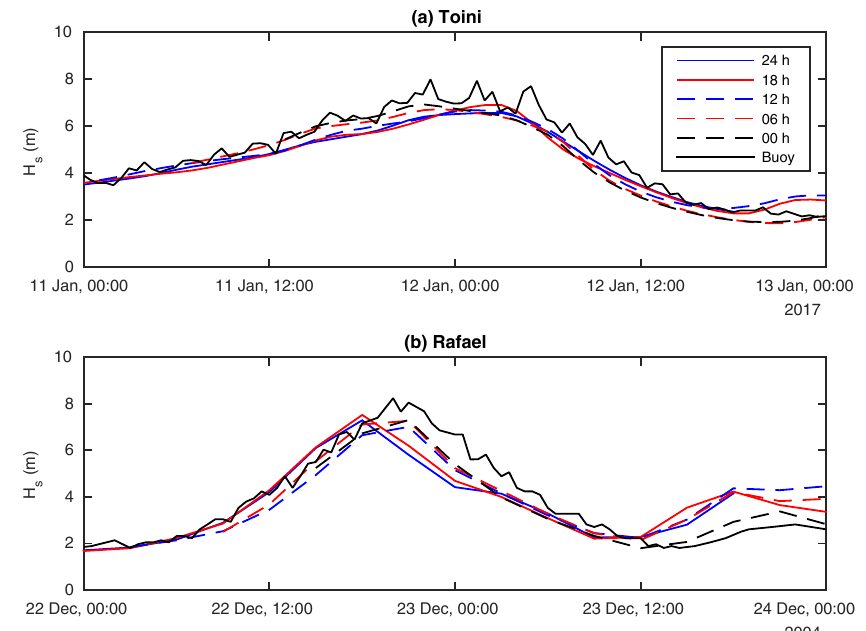
Figure 2. Forecasts for the significant wave height H s for storms Toini (a) and Rafael (b) . The notation “12h” means that the forecast was available 12h prior to the observed maximum. The continuous black line is the values measured by the NBP wave